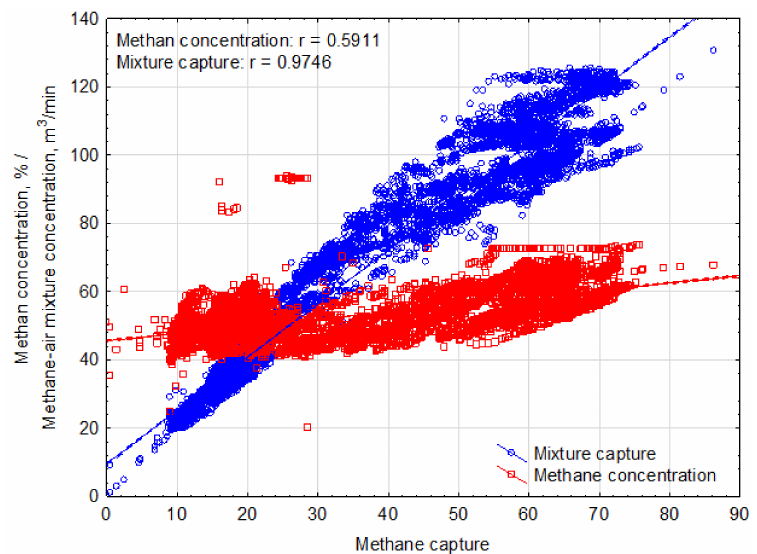
Figure 6. Methane concentration and methane-air mixture capture as a function of methane